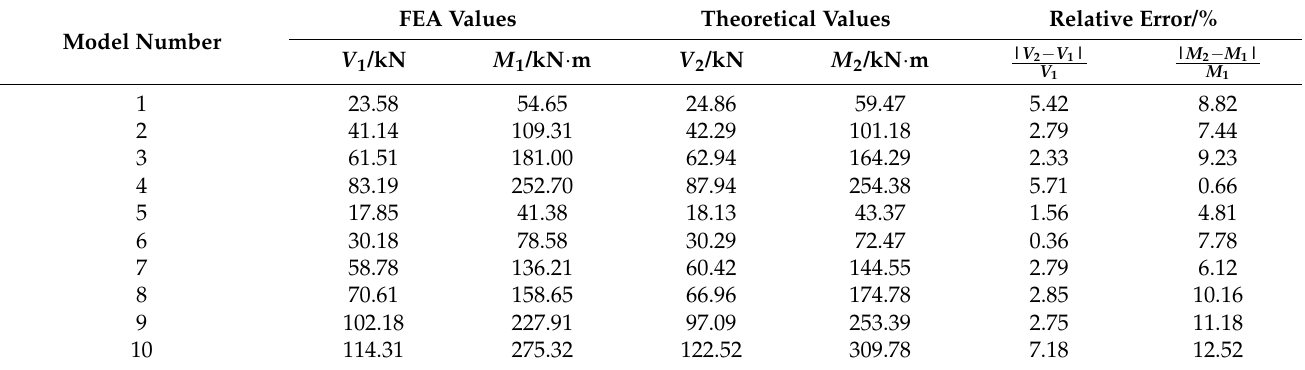
Table 3. Comparison of FEA values with theoretical values.